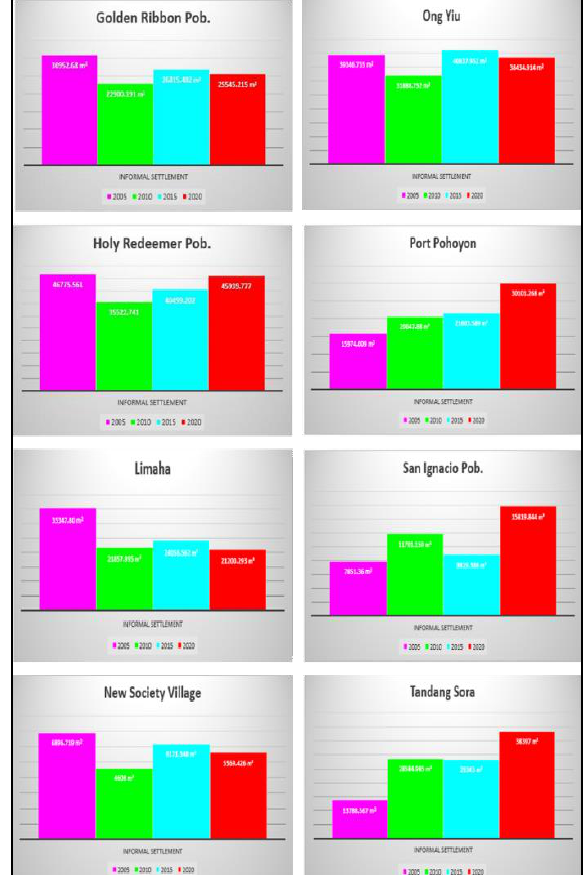
Figure 19. Rate of change of Informal Settlements of the eight (8) barangays in Butuan City Butuan City